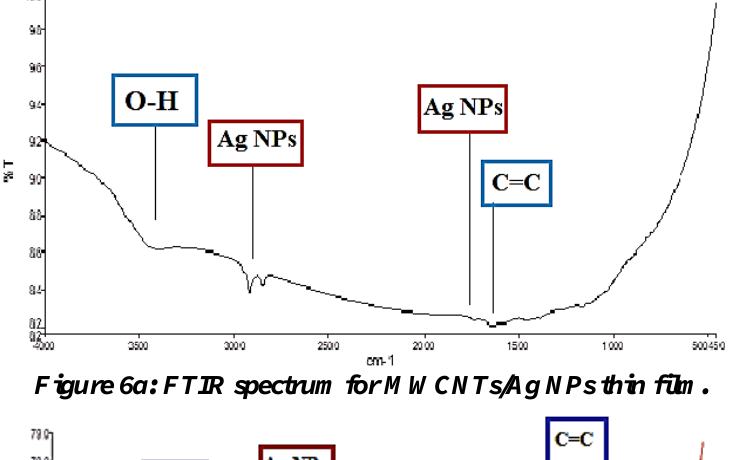
Figure 6a: FTIR spectrum for MWCNTs/Ag NPs thin film.